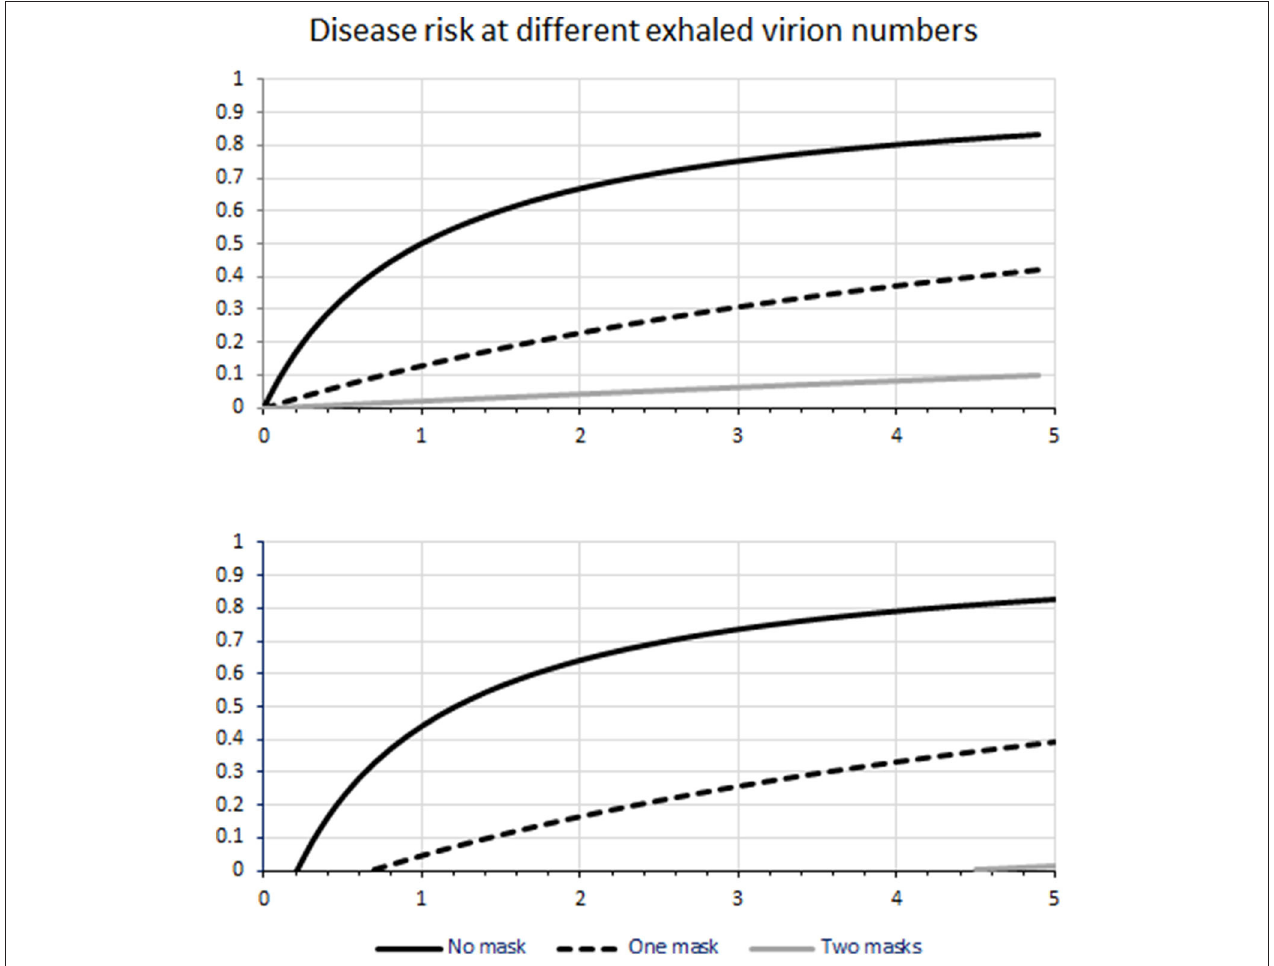
FIGURE 2 | A sketch that attempts to illustrate the transmission of respiratory pathogens through masks worn by infected virus sources and uninfected recipients. The calculations assume a simple bimolecular interaction between the virus and its receptors. The units on the horizontal axis are arbitrary. The vertical axis shows the likelihood of being infected. Notice the short line in the lower right of (B) ; this figure concerns two mask-protection in case there would be a minimally infectious dose well above 1. (A) shows the situation in the absence of a minimal infectious